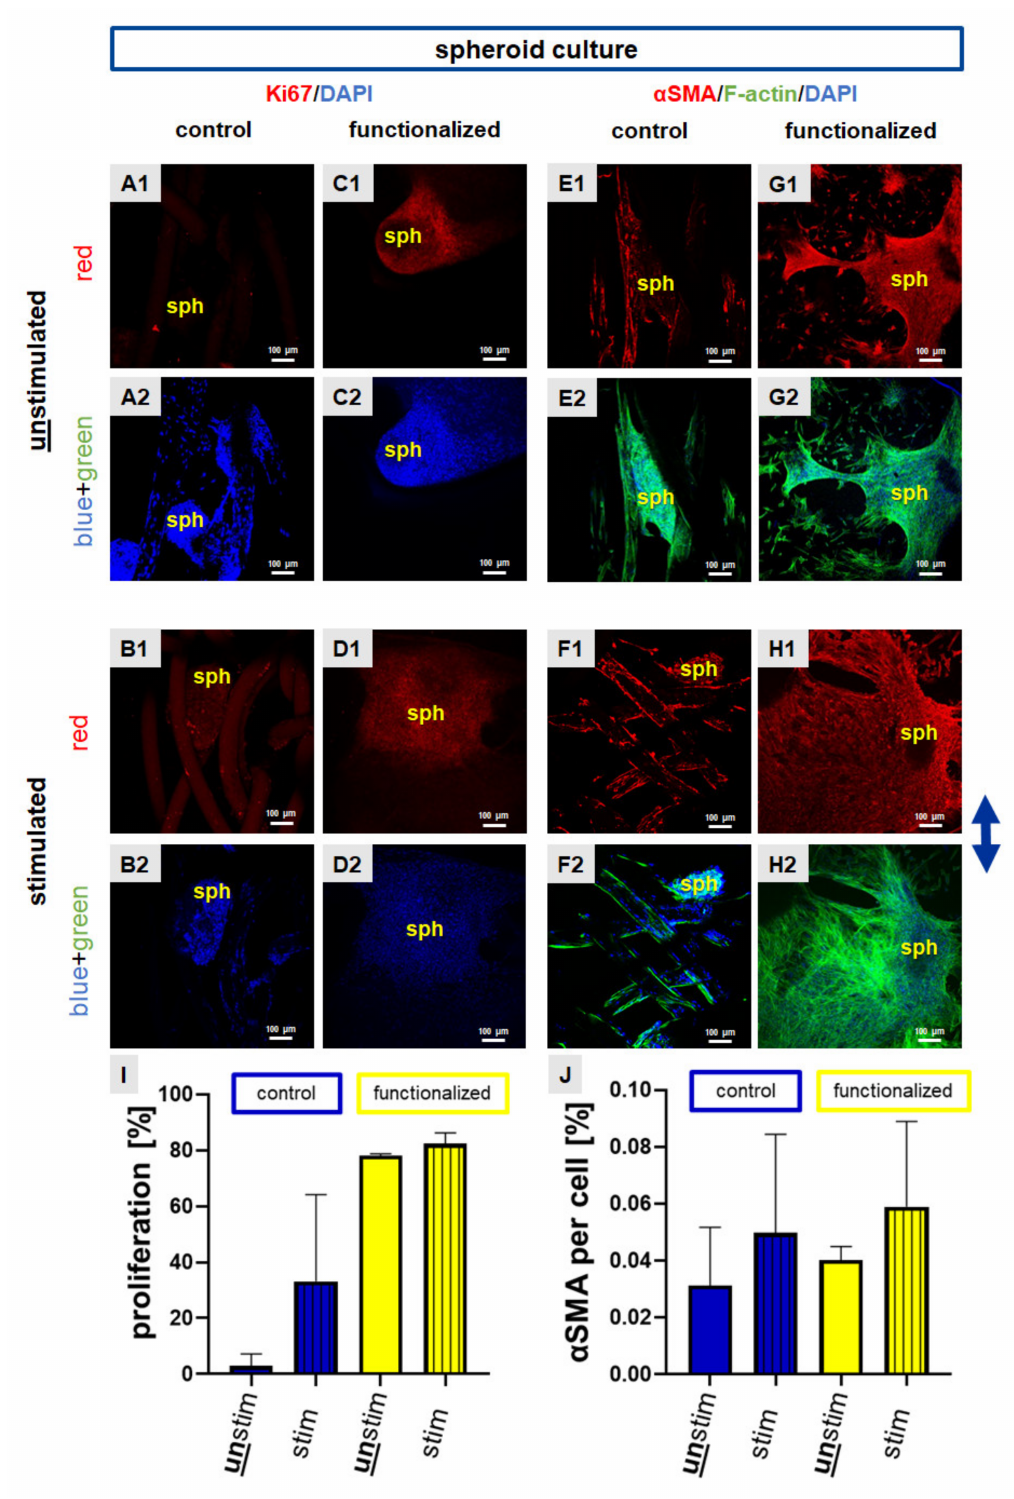
Figure 5. Ki67 and α SMA protein expression in scaffolds seeded with the spheroid (sph) culture. Scaffolds were statically pre-cultured for 5 days. Immunocytochemical staining of Ki67 (red) was performed for control ( A , B ) and functionalized scaffold ( C , D ). Immunocytochemical staining of the myofibroblast marker alpha smooth muscle actin ( α SMA, red) combined with staining of F-actin (green) was performed for control ( E , G ) and functionalized scaffolds ( F , H ). Unstimulated ( A , C , E , G ) scaffolds were compared with stimulated ( B , D , F , H ). The proliferation rate ( I ) and α SMA immunoreactivity per cell (%) ( J